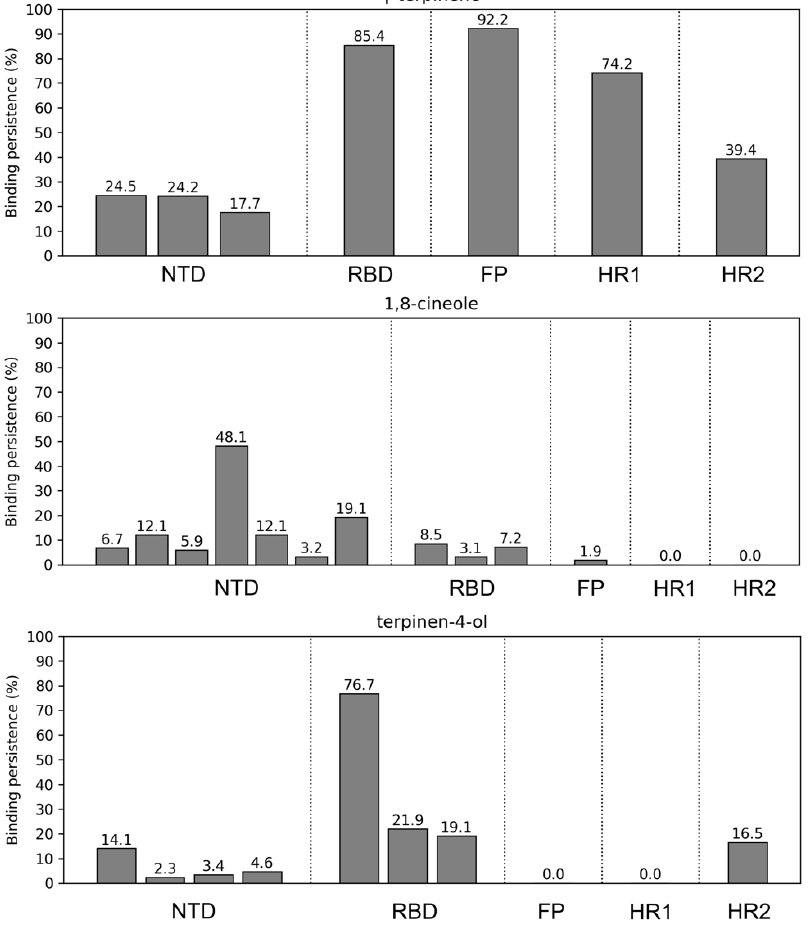
Figure 3. Binding persistence of all TTO molecules contacting the S functional domains during the simulation time. The number of bars represents, for each domain, the number of γ -terpinene, 1,8-cineole, or terpinen-4-ol molecules bound to that domain. The height of the bars indicates the percentage of simulation time in which the molecule was in contact with the domain. Percentage values are also reported on top of bars. (NTD: N-terminal domain, RBD: receptor binding domain, FP: fusion peptide, HR1: heptad-repeats 1, and HR2: heptad-repeats